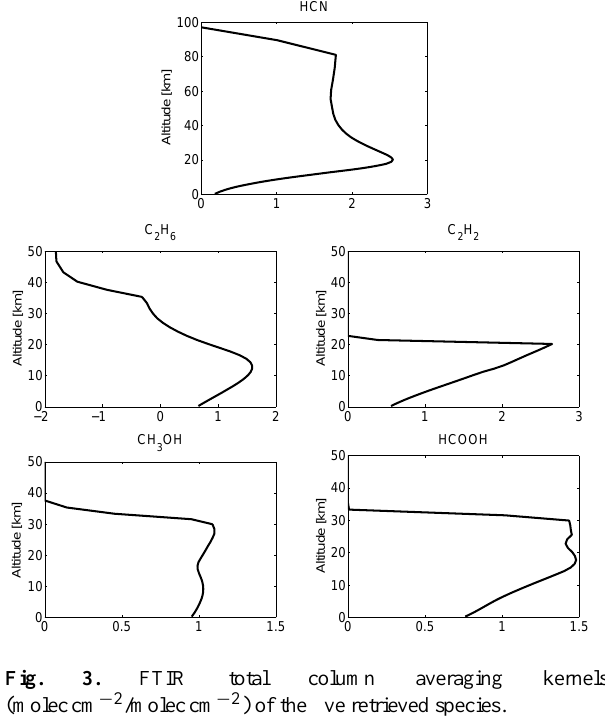
Fig. 3. FTIR total column averaging kernels (moleccm − 2 /moleccm − 2 ) of the five retrieved species.